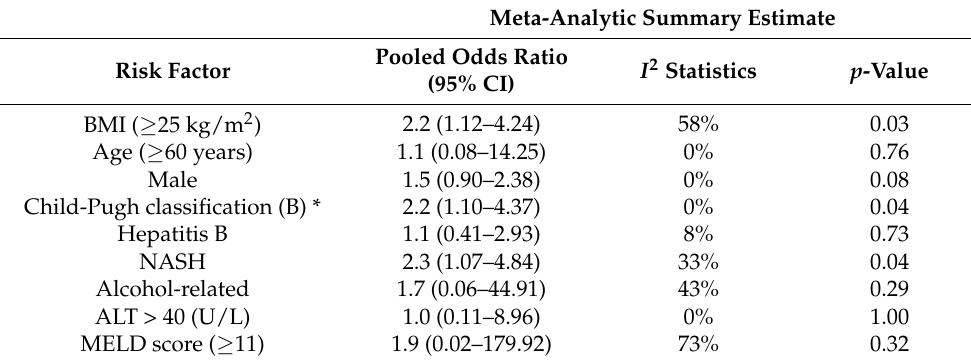
Table 3. Pooled odds ratios of the risk factors for inadequate US